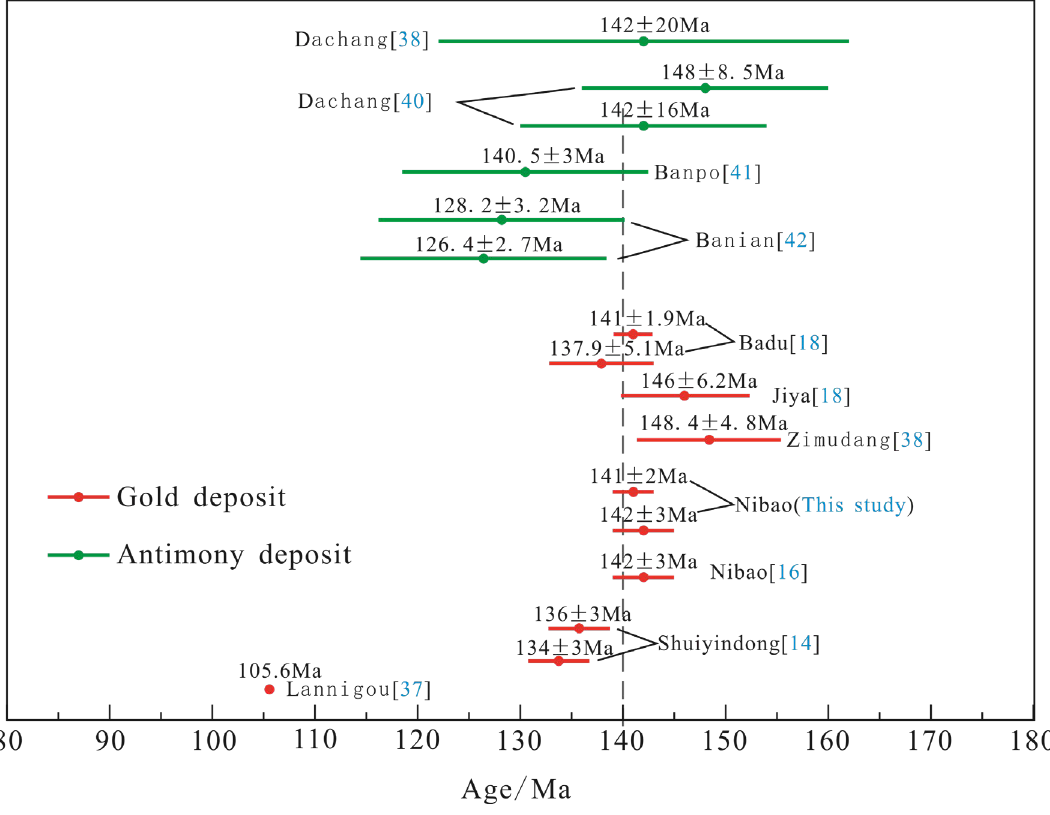
Figure 8. Mineralization ages of the gold and antimony deposits in the Yunnan–Guizhou–Guangxi Golden triangle region.